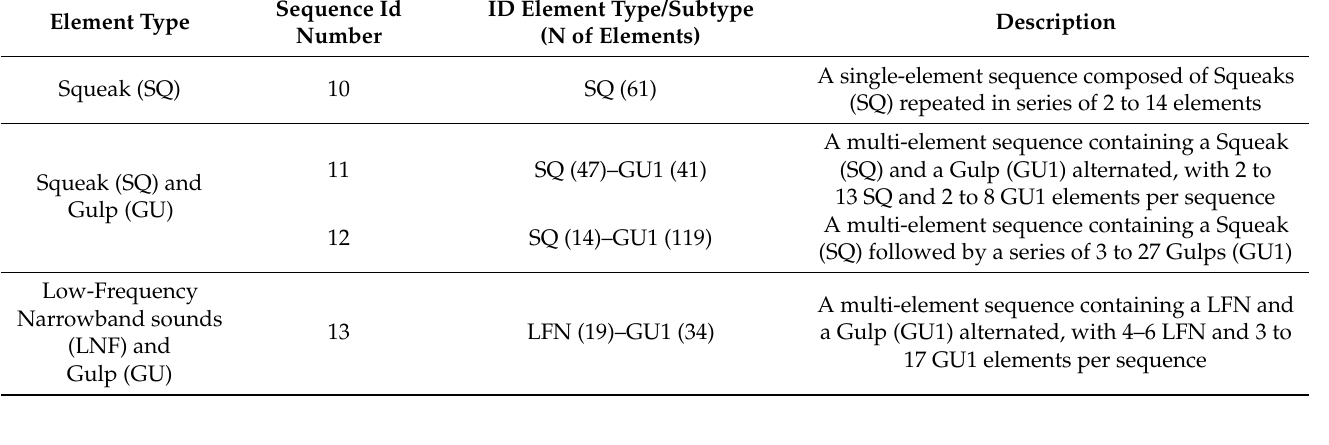
Table 3. Parameters measured for each bray call series and for each single element composing the sequence.